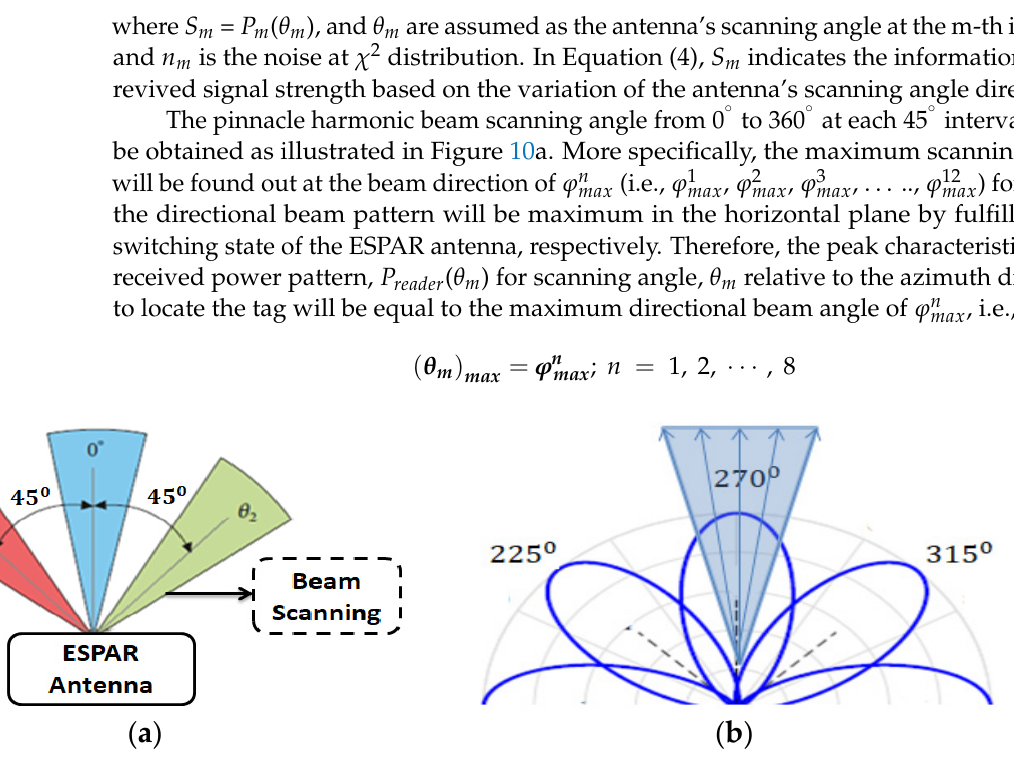
Figure 10. Beam scanning at different directional angle: ( a ) BS of the ESPAR antenna at respective directions; ( b ) BS at 270 ◦ followed by angular beam direction at each 45 ◦